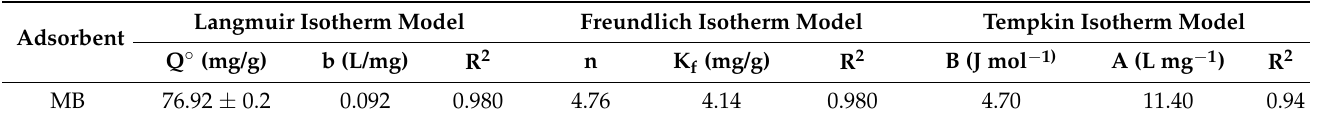
Table 5. Calculated equilibrium constants for adsorption of